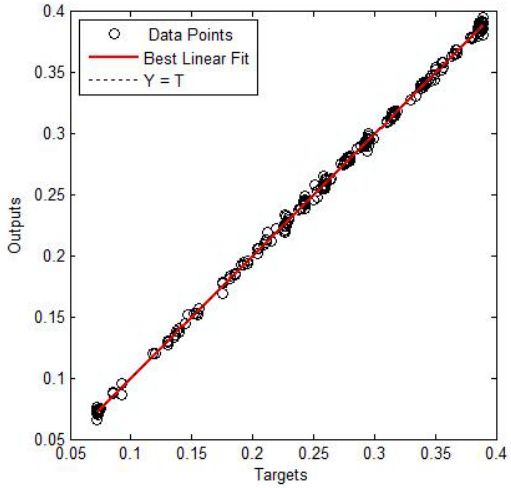
Fig. 3. Linear regression between the targets and outputs on the training data set, R=0.998